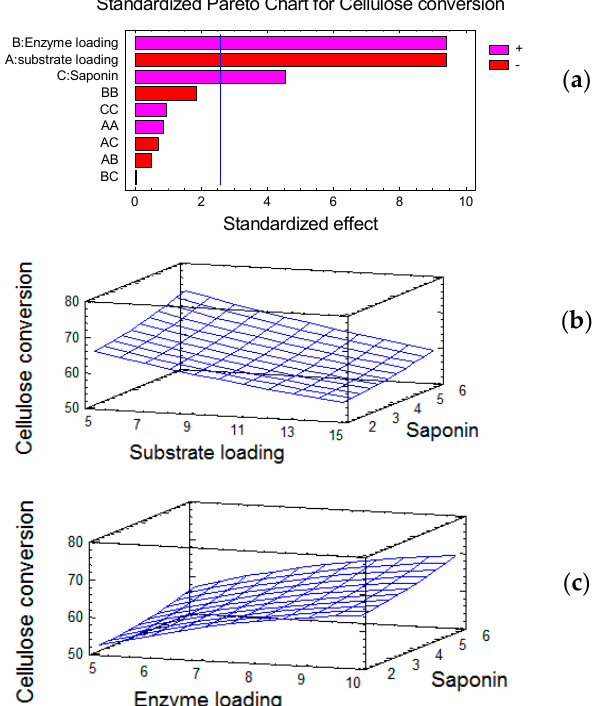
Figure 1. Cellulose conversion during the enzymatic hydrolysis of SPS with different RQS dosages under different loadings of enzymes and substrate. Pareto chart of standardized effects on cellulose conversion (positive, +; negative − ) ( a ), and response surface plots at constant loading of enzyme ( b ) and substrate ( c ).